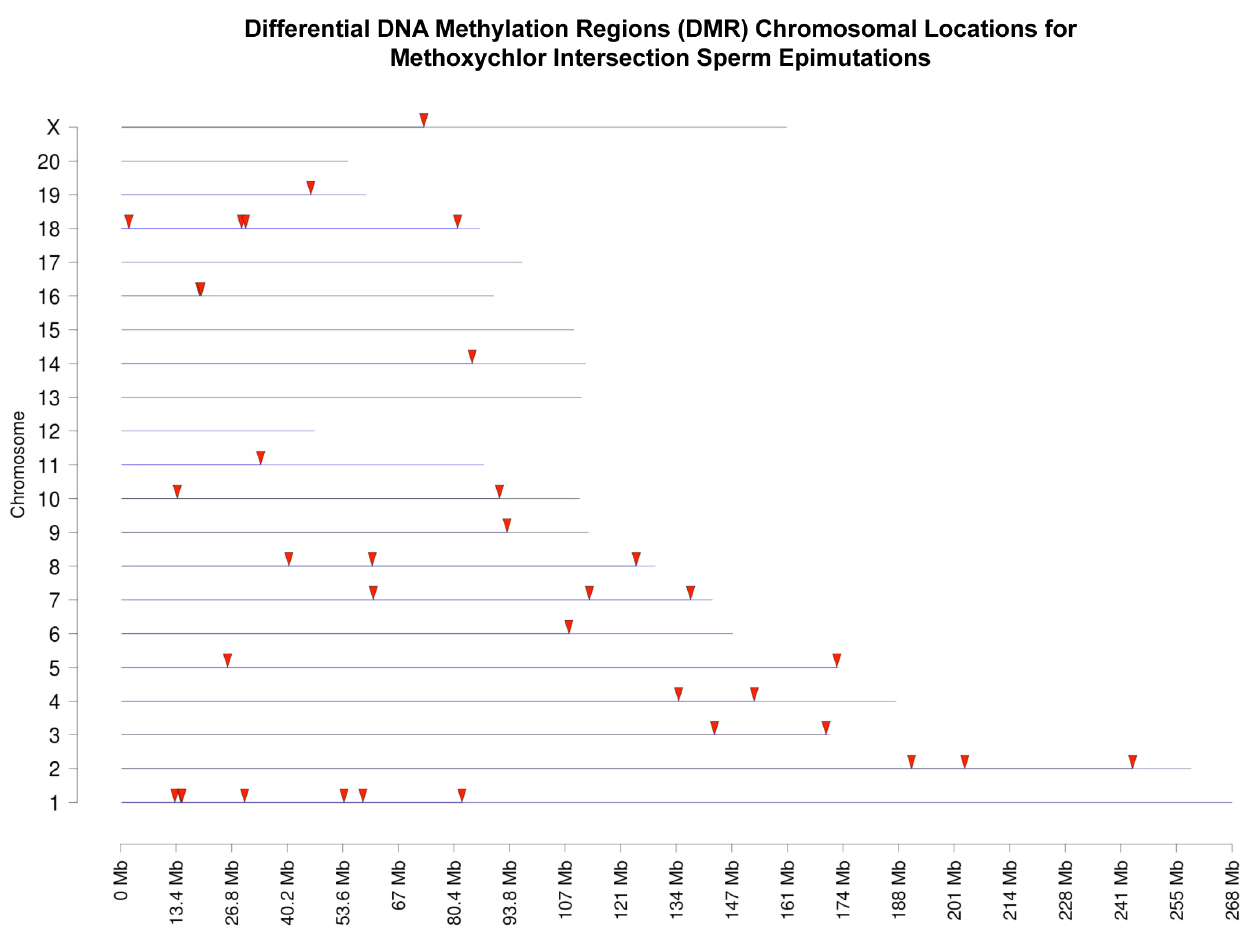
Figure 7. Ancestral exposure to methoxychlor and transgenerational epigenetic changes and induced sperm intersection epimutations. Chromosomal locations for regions with transgenerational change in DNA methylation (arrowheads). There were 37 differentially methylated regions in sperm DNA from methoxychlor lineage rats compared to control lineage rats for all three experiments.